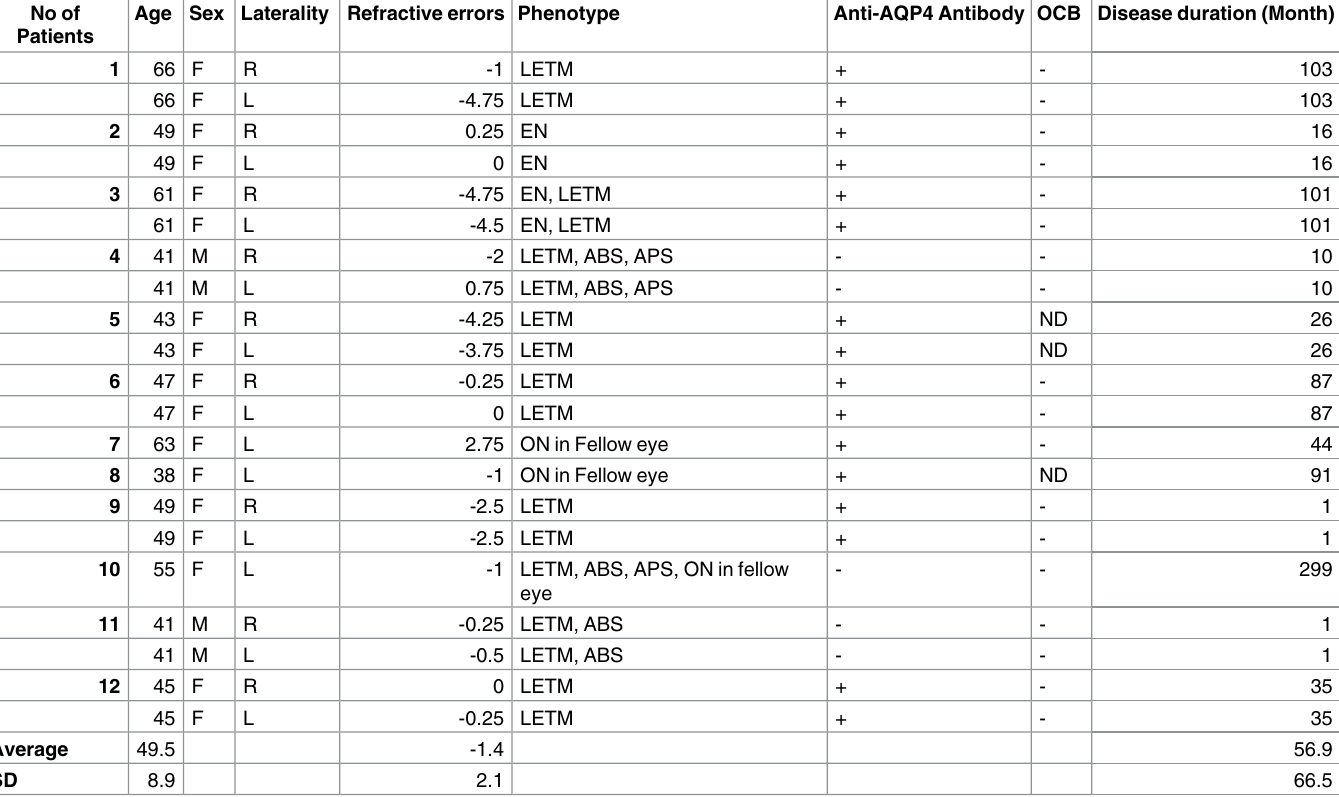
Table 1. Clinical characteristics of patients with NMOSD. No of